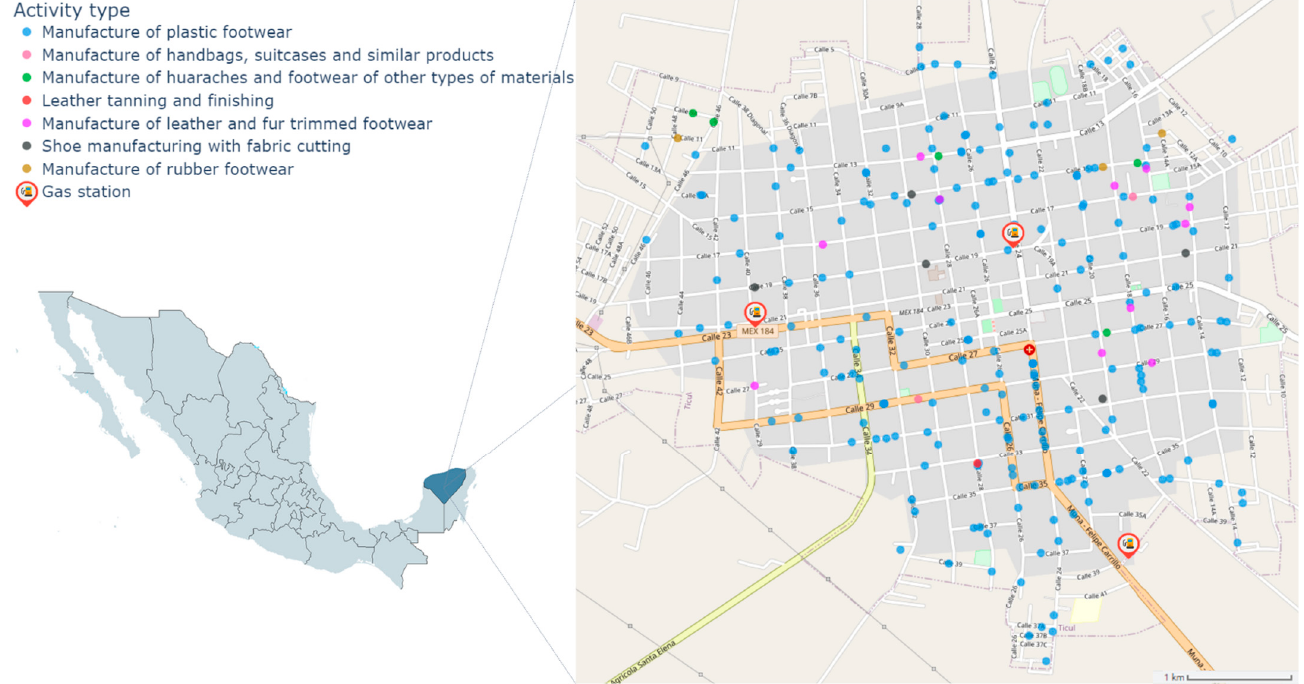
Figure 1. Map of Ticul with the locations of shoe workshops.